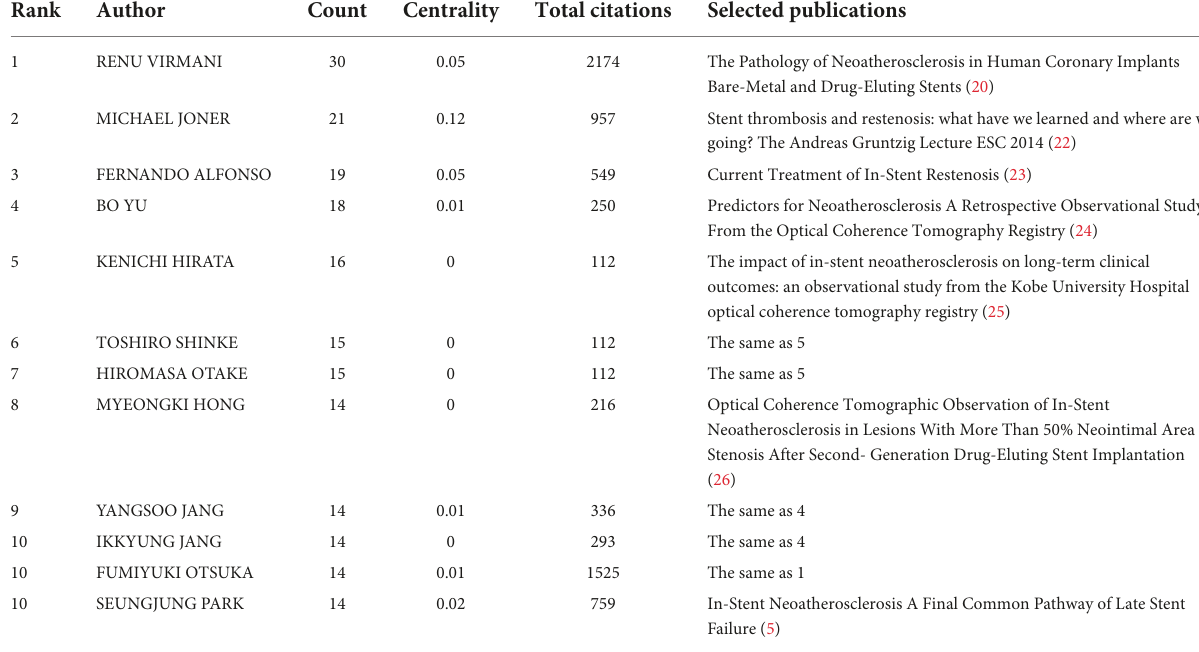
TABLE 2 The top 10 authors with the highest number of articles and their representative